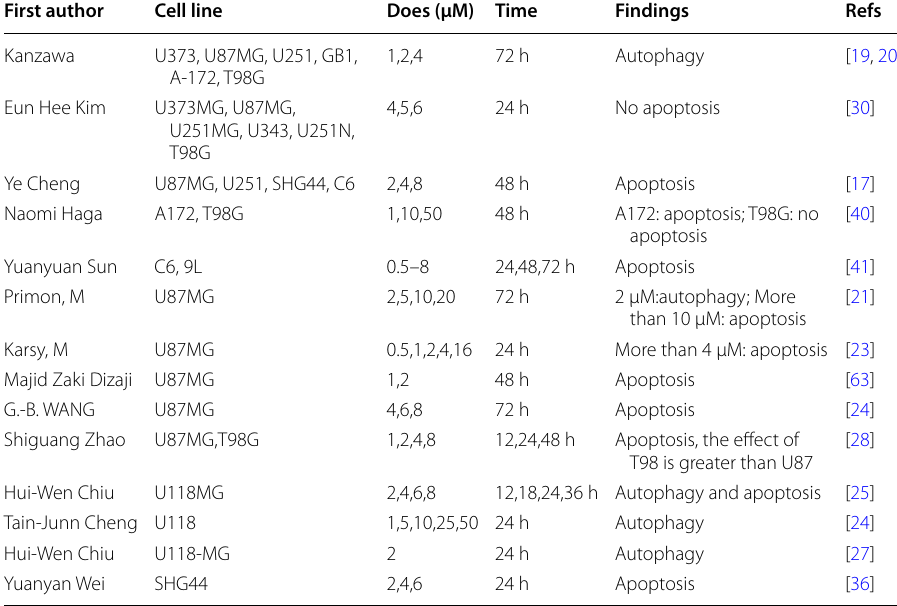
Table 1 Studies on arsenic trioxide-induced glioma cell